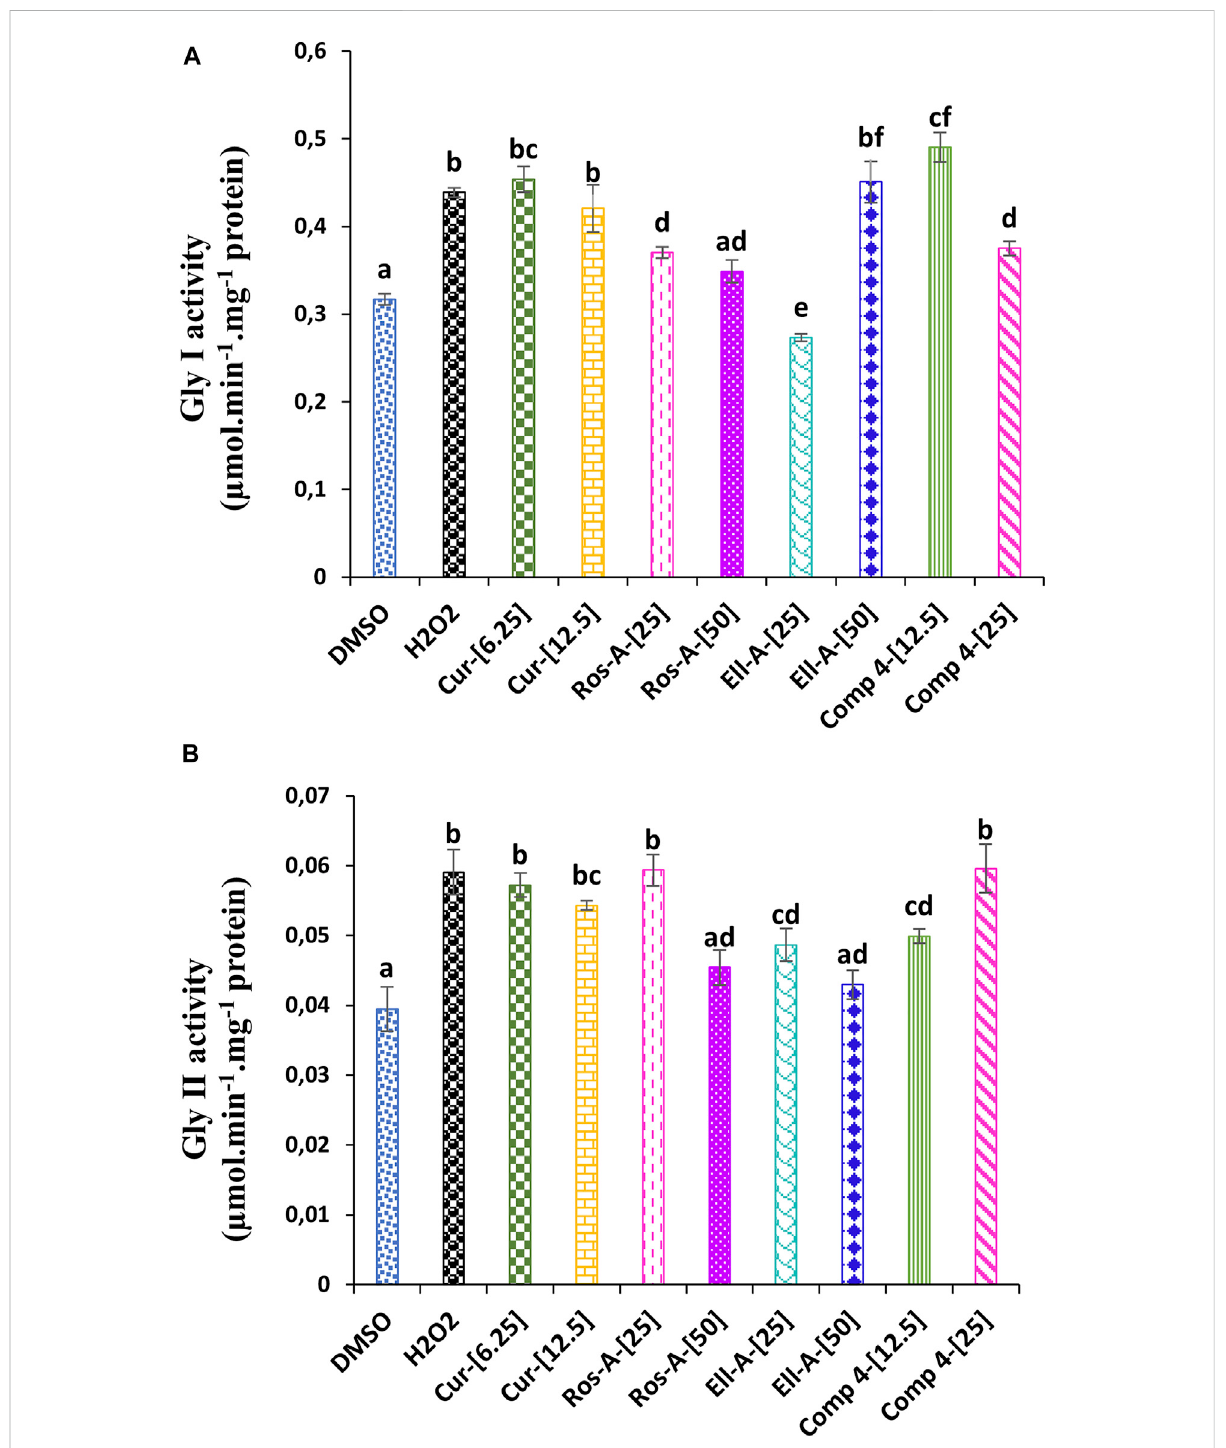
FIGURE 5 EffectofCur,Ros-A,Ella-AandComp4onglyoxalasesysteminTHP-1cellstreatedwithH 2 O 2 . (A) GlyIactivityonTHP-1treatedH 2 O 2 . (B) GlyII activity onTHP-1 treated H 2 O 2 . Each valuerepresents themean ofthree replicate. Bars represent standard error. Different letters indicate signi fi cant differences among treatment at p <